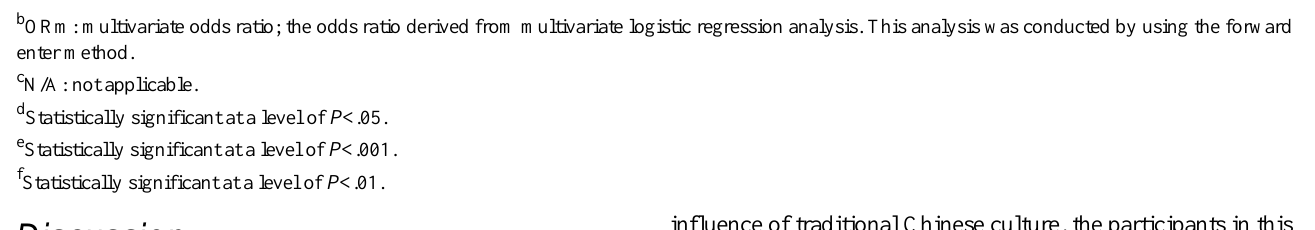
b ORm: multivariate odds ratio; the odds ratio derived from multivariate logistic regression analysis. This analysis was conducted by using the forward enter method. c N/A: not applicable. d Statistically significant at a level of P <.05. e Statistically significant at a level of P <.001. f Statistically significant at a level of P